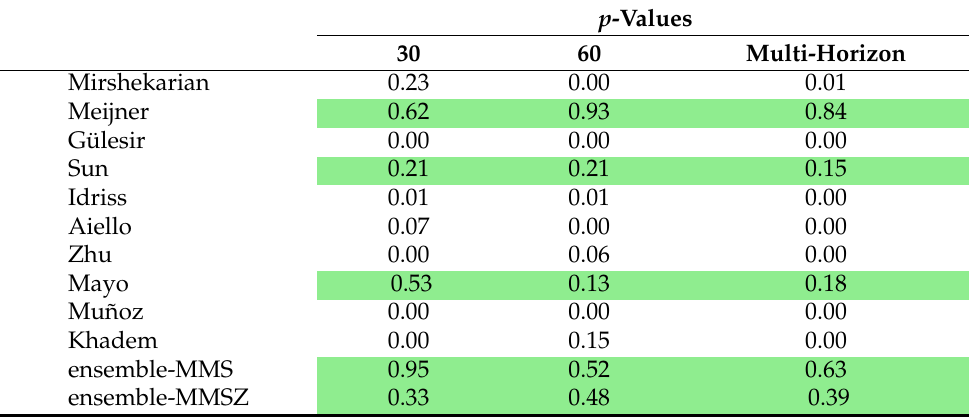
Table 15. p -values for the SPA using each model as benchmark for ph = 30,60,30 ∪ 60. Green cells in each column highlight the model with the best